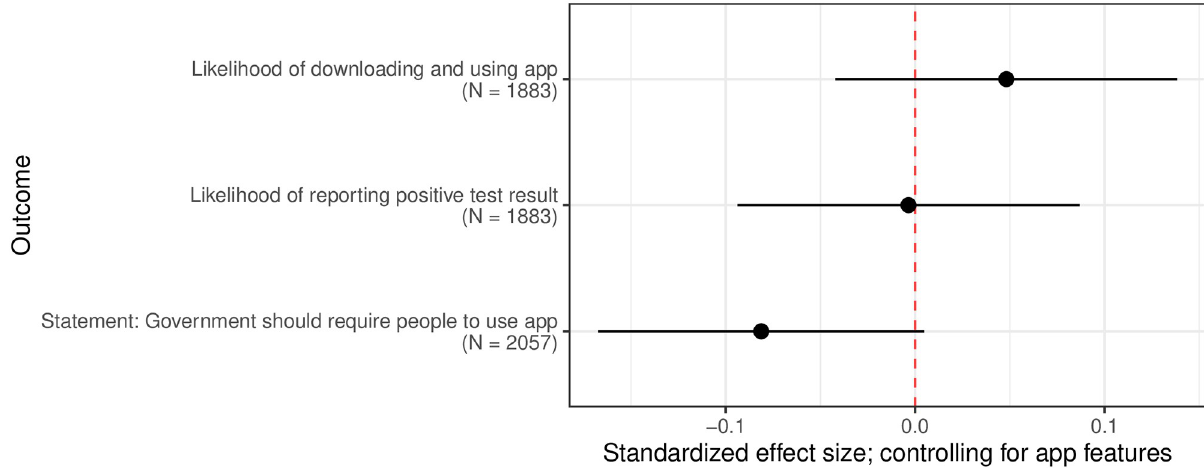
Fig 5. Estimated effects of COVID-19 experience question section priming on support for smartphone apps, with 95% confidence intervals. A randomly selected half of respondents were asked a section of questions regarding their own experiences with COVID-19 prior to questions regarding their support for a hypothetical contact tracing app (the “prime” condition), while the other half were asked these questions afterward (the “control” condition). The quantities depicted show the estimated effects of being assigned to the prime condition, compared to the control condition, on the various measure of support for the contact tracing app. Coefficients come from a saturated linear regression controlling for hypothetical app features.